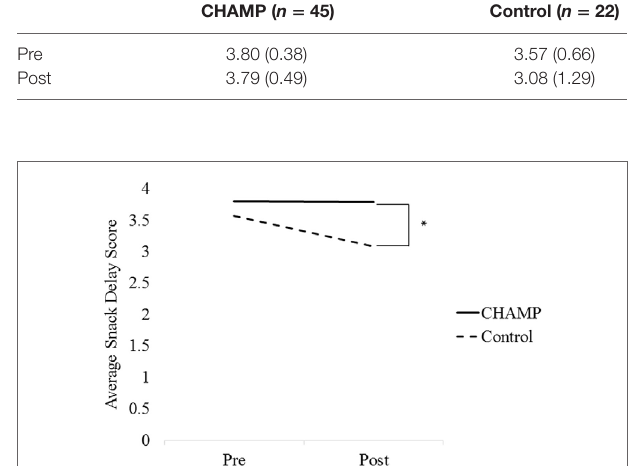
FigUre 3 | Delay of gratification scores across time according to treatment group .